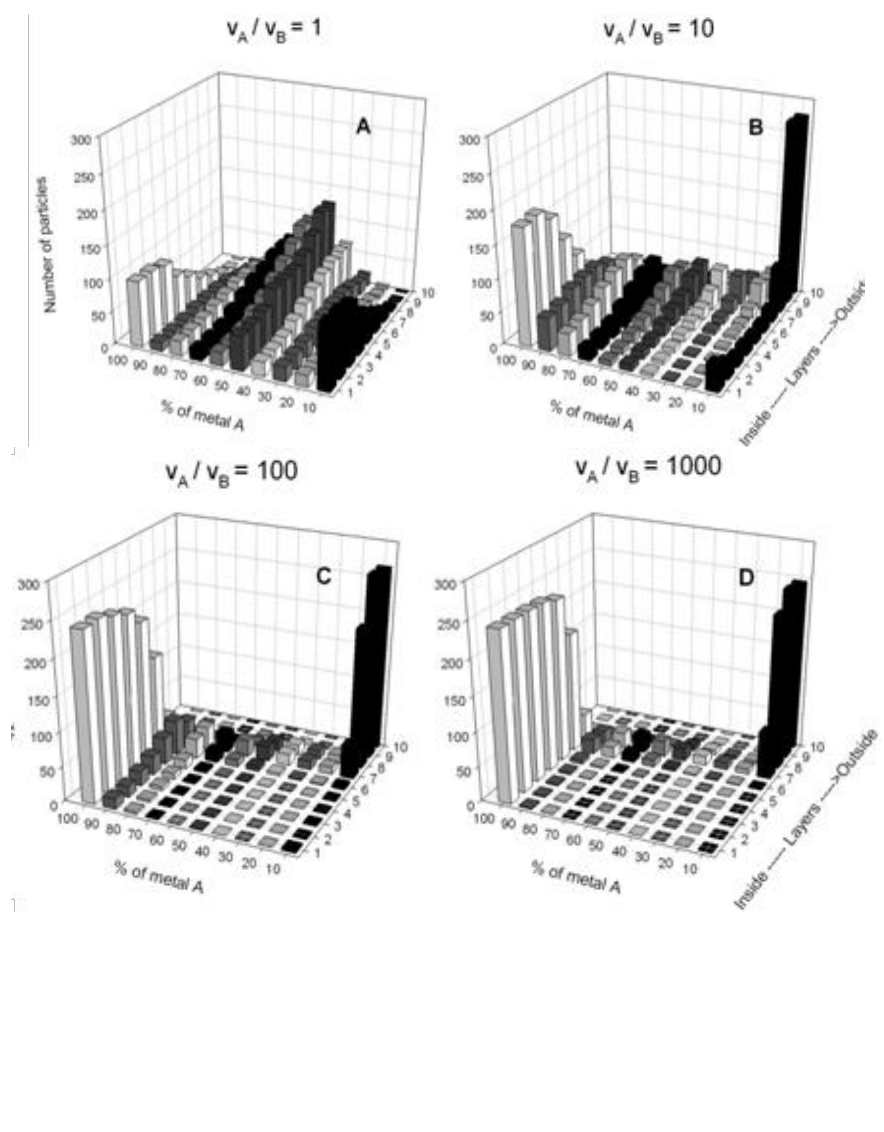
Figure 4. Number of particles versus the percentage of one of the products ( AM ), from the nanoparticle core to the outside (layer by layer) for different reduction rate ratios, and keeping the synthesis variables constant: reactant concentration  c k = 1, n* = 1, no restriction by droplet size. ( A ) v ex ( C ) v /v = 100; ( D ) v /v = A B A B